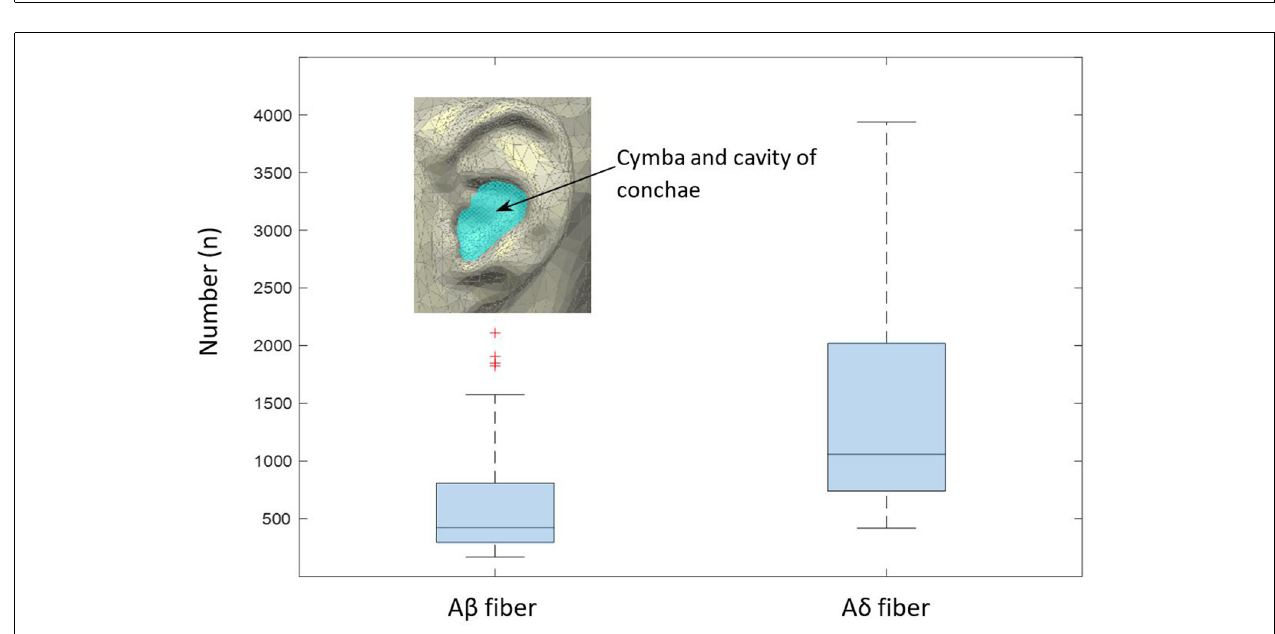
FIGURE 8 | Probability distribution of diameters for different